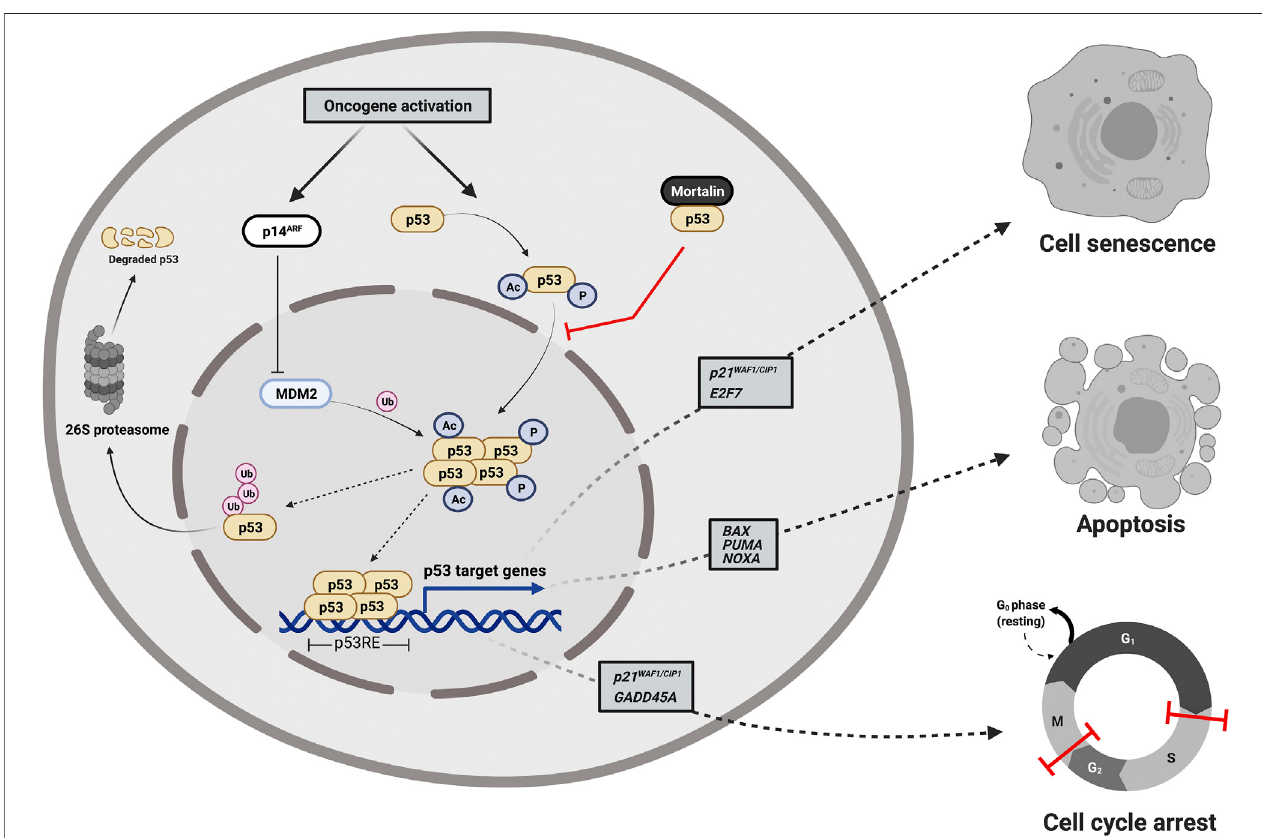
FIGURE1| Cellular responses tooncogene-dependentactivationofp53signaling.Oncogenicstresssignalsactivate p53directlythroughtheactivationofvarious kinases and acetyl transferases that post-translationally phosphorylate and acetylate p53 to be stabilized, accumulated, and translocated to the nucleus and indirectly throughtheinductionofthep14 ARF tumor suppressorthatbindstoMDM2 preventingitsinteractionwithp53andhaltingtheproteosome-mediateddegradationofp53. Upon translocation to the nucleus, tetramerized p53 acts as a DNA-sequence speci fi c transcription factor transactivating a set of genes responsible for tumor suppression programs (apoptosis, cell cycle arrest and cell senescence). Mortalin binds to p53 sequestering it in the cytoplasm and preventing its transcriptional activation functions. The fi gure was created using (www.app.biorender.com).